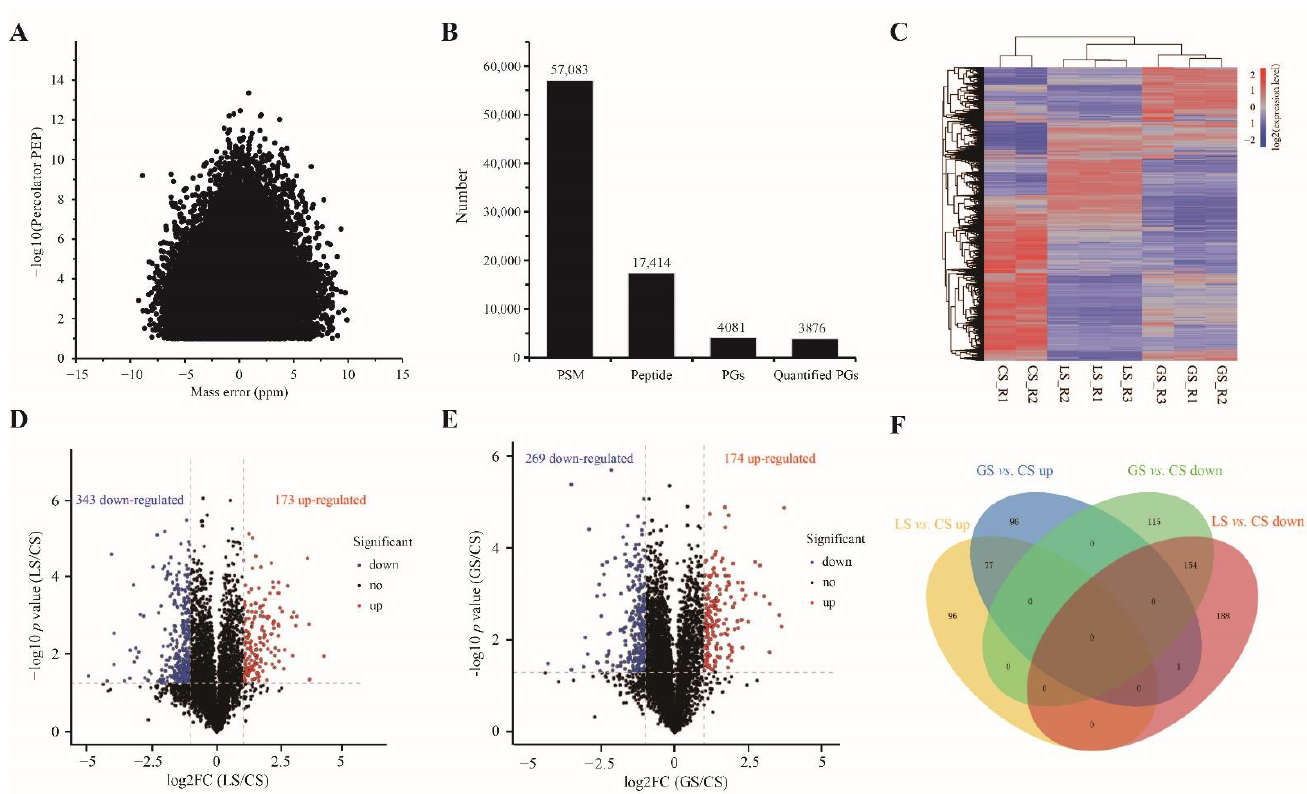
Figure 3. Summary statistics of the differential proteomics: ( A ) distribution of peptide mass error; ( B ) distribution of total protein. PSM: peptide-spectrum matches, PGs: protein groups; ( C ) the cluster heatmap of all quantitative protein abundance levels. Blue represents an abundance level below the mean, and red represents an expression level above the mean; ( D ) the volcanic plot of the LS vs. CS comparison group; ( E ) the volcanic plot of the GS vs. CS comparison group (Blue: downregulated; Red: upregulated; Black: no difference); and ( F ) Venn diagram of the two comparison groups.